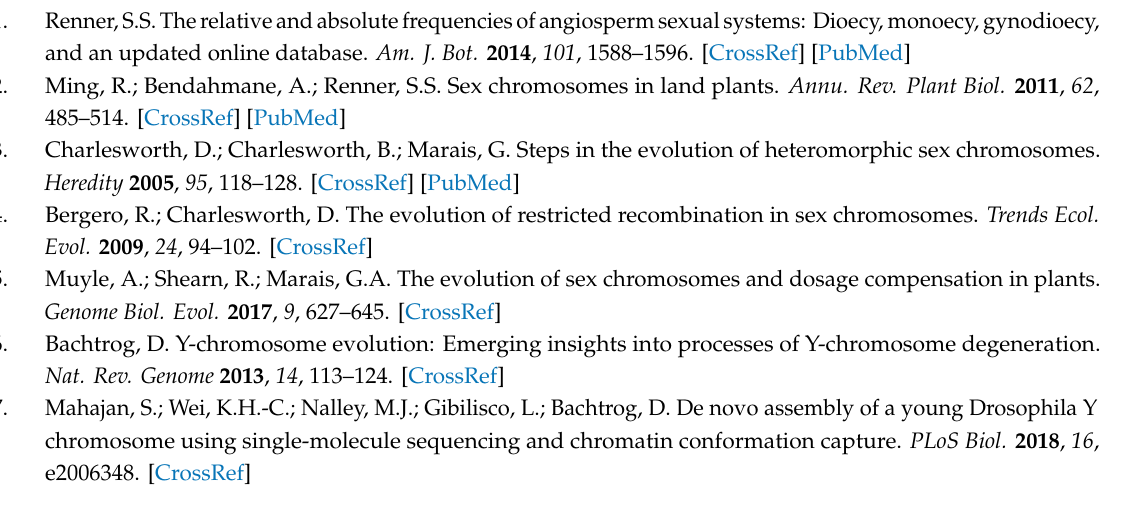
Figure S1: Distribution of pairwise synonymous divergence (dS) between X and Y alleles in X / Y contigs, Figure S2: Expression levels of autosomal and sex-linked contigs in both sexes before and after correction, Figure S3: Male vs. female autosomal gene expression ratio after correction, Figure S4: Male vs. female sex-linked gene expression ratio after correction, Figure S5: Venn diagram of Di ff erentially Expressed Genes identified by DESeq2, edgeR, and LimmaVoom, Table S1: Library sizes and statistics for RNA sequencing from C. grandis male and female flower buds, Table S2: BUSCO results for C. grandis flower bud transcriptomes, Table S3: Mapping statistics of all the samples, Table S4: Number of Di ff erentially Expressed Genes (DEG) per gene